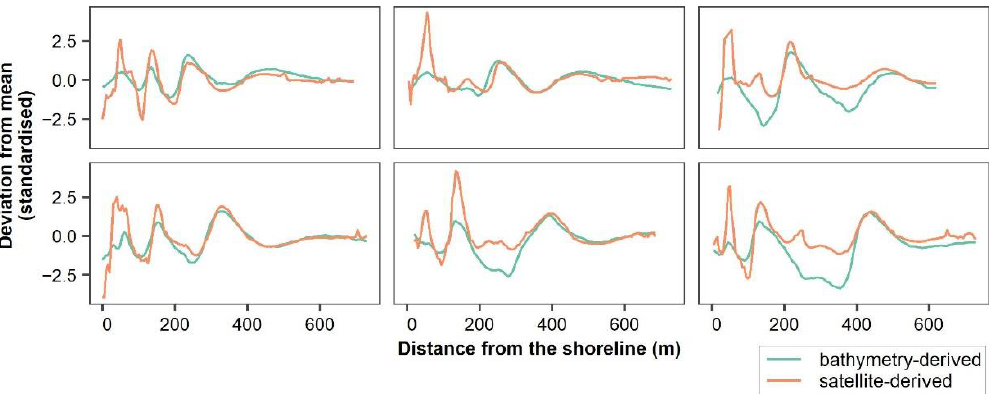
Figure 13. Cross-shore profiles of bathymetry-derived and RBPI-derived perturbations (values were standardised for comparison) at different alongshore locations in the Curonian Spit. Bathymetric surveys were conducted on the 19 May 2019, and a satellite image was acquired on the 22 May 2019.